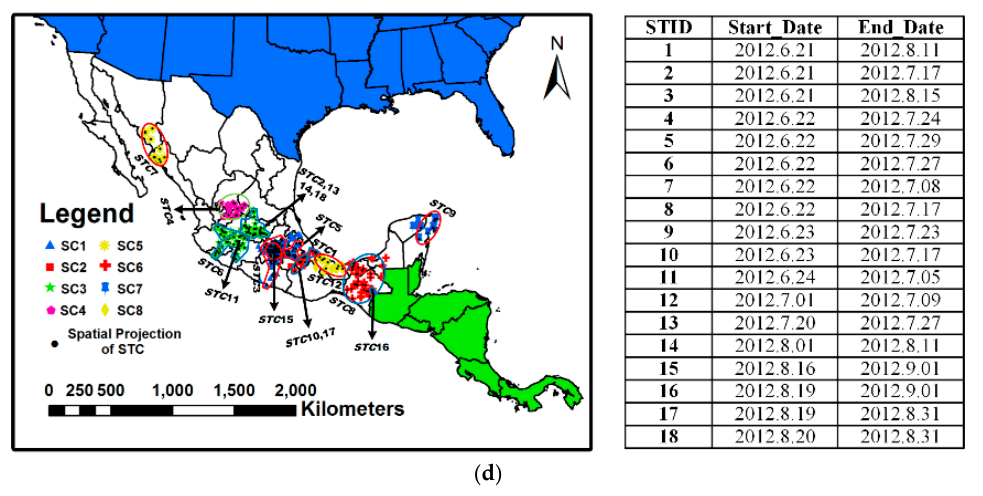
Figure 15. The evolving spatio-temporal patterns discovered for STTE with the parameters δ = 2, ε = 2. ( a , b ) the evolving spatio-temporal patterns of spatial outliers and their spatial locations and time ranges; ( c , d ) the evolving spatio-temporal patterns of spatial clusters and their spatial locations and time ranges.